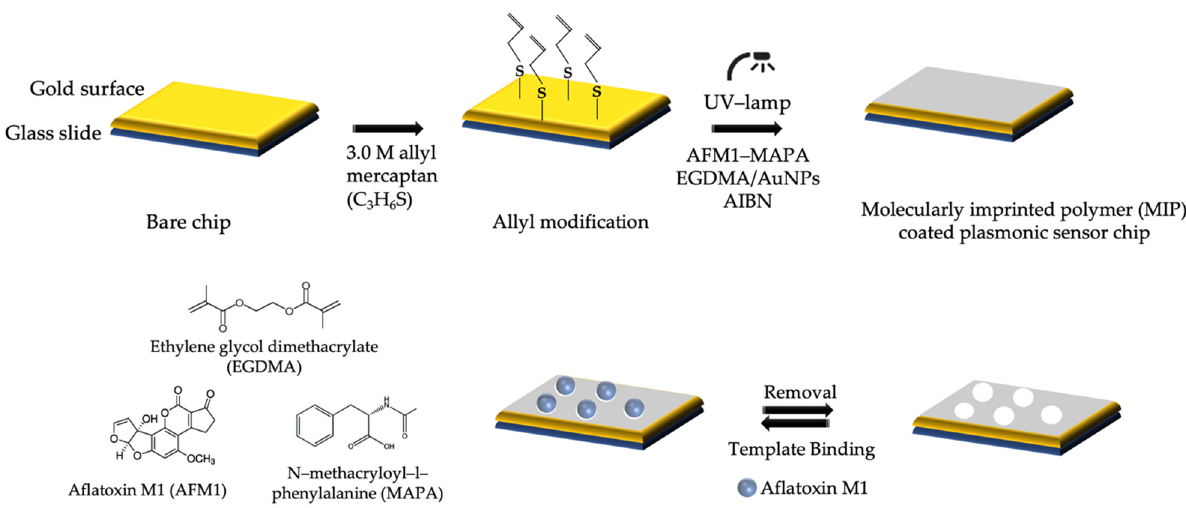
Figure 1. Schematic representation of MIP–based plasmonic sensor chip fabrication process.